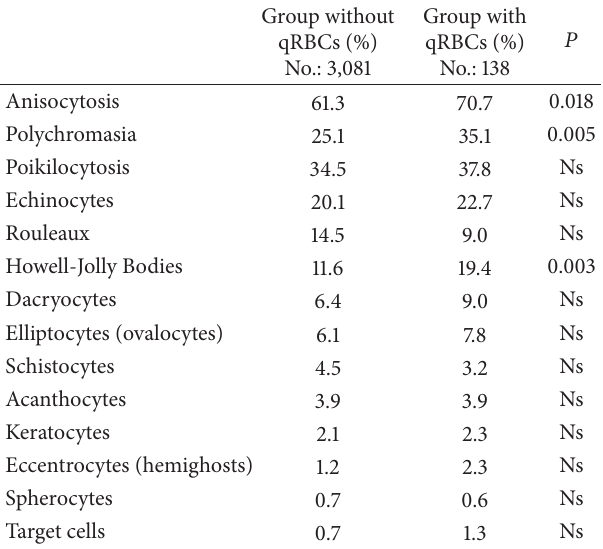
Table 4: Distribution of standard erythrocyte modification findings (according to [12]) in two groups of dogs without quatrefoil RBCs or with quatrefoil RBCs.